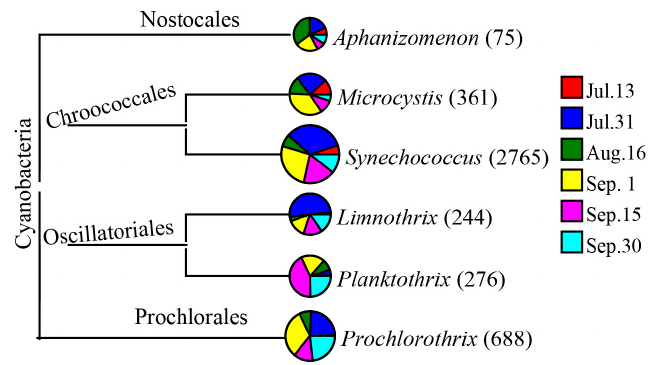
Figure 3. Taxonomic classification of cyanobacterial community in Zhoucun drinking water reservoir from July to September, 2012. Number in the bracket represents OTUs number.